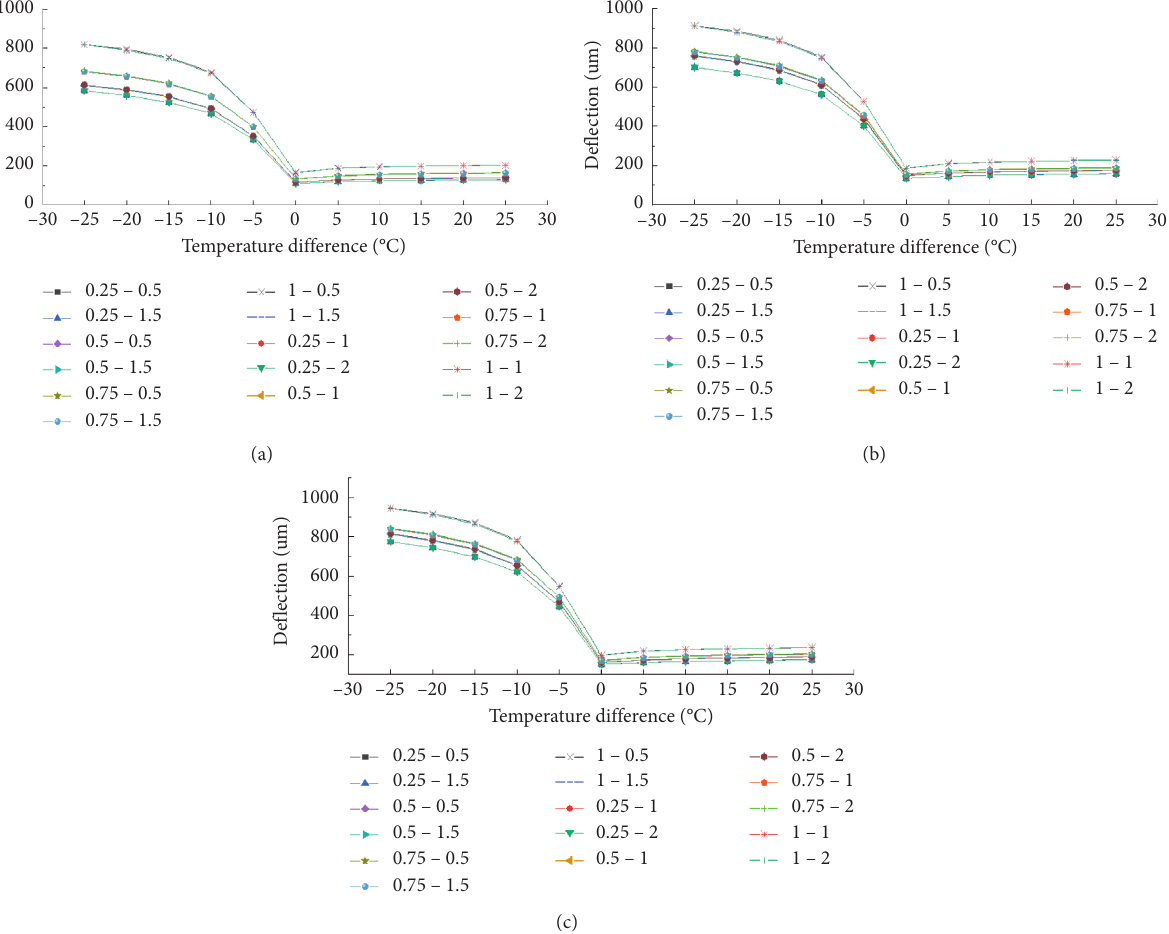
Figure 4: Deflection of plate angle load center point for plate angle voids. (a) 50 kN. (b) 70kN. (c) 90kN.